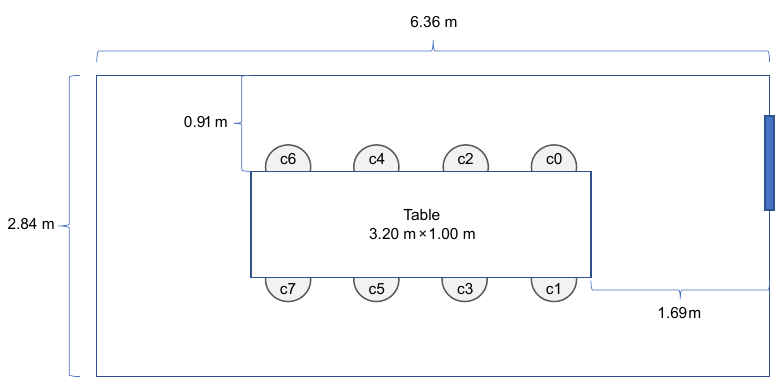
Figure 2. Floorplan of the room used in the study showing seats c0–c7.